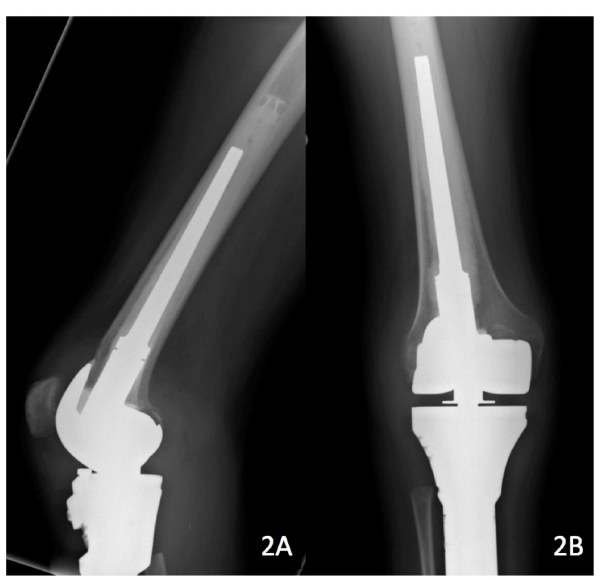
Figure 2. 8 week post-op lateral (A) and AP (B) x-ray imaging demonstrating no signs of recurrence, hardware failure, or